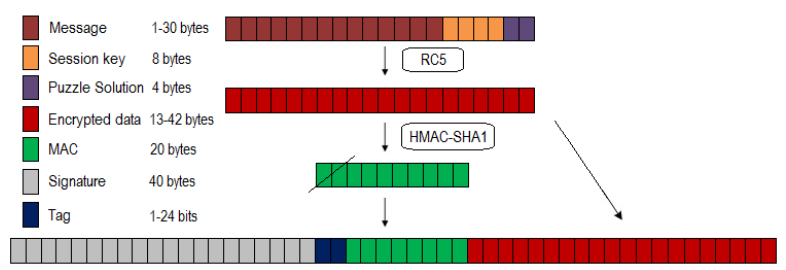
Figure 8. DCP packet content.